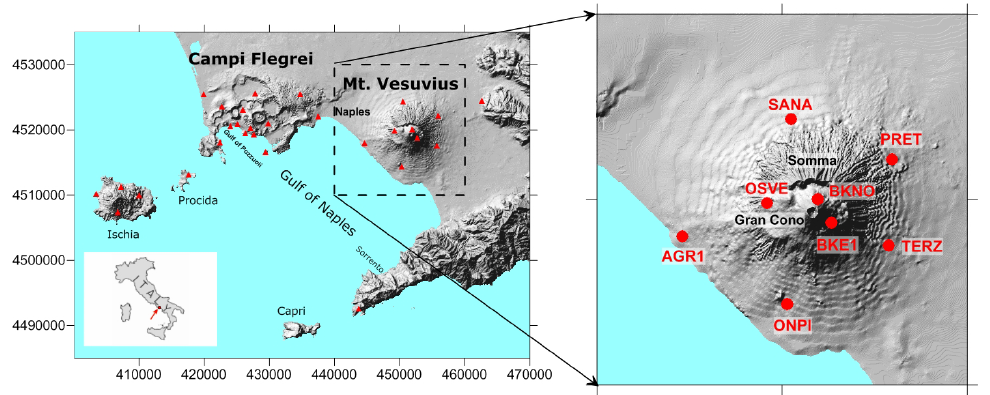
Figure 1. NeVoCGPS network. Red triangles indicate GPS stations of the network. In the insert box, the nine stations used in this study are shown.